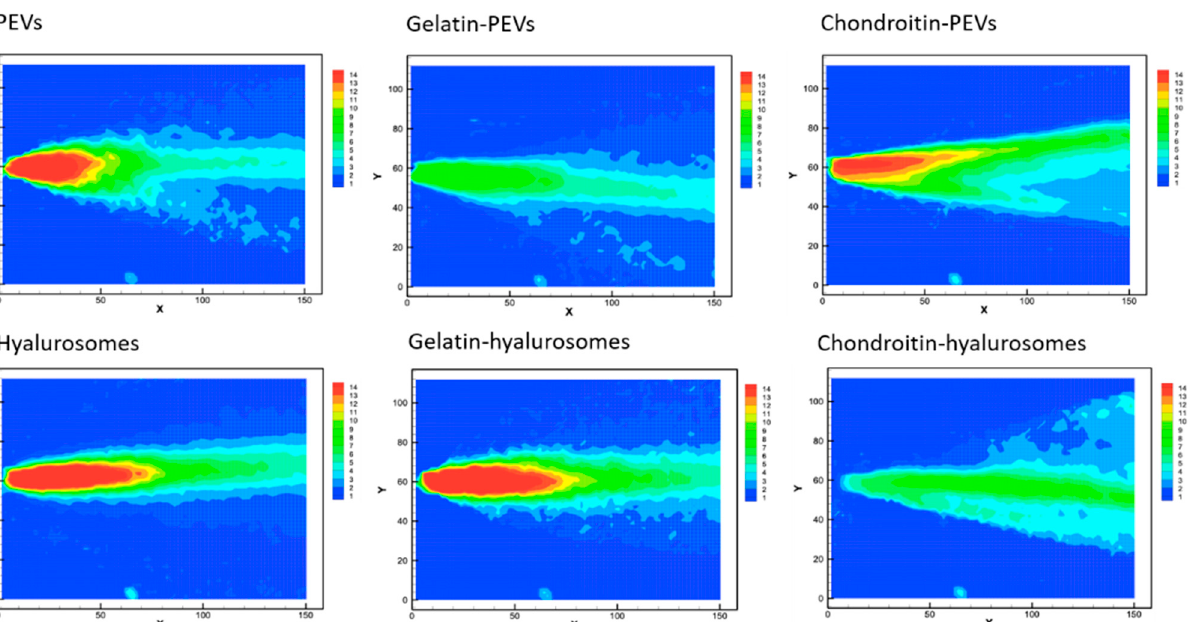
Table 3. High speed values and spray angle measured from the plume generated by C. halicacabum extract-loaded PEVs; gelatin-PEVs; chondroitin-PEVs; hyalurosomes; gelatin-hyalurosomes; and chondroitin-hyalurosomes.